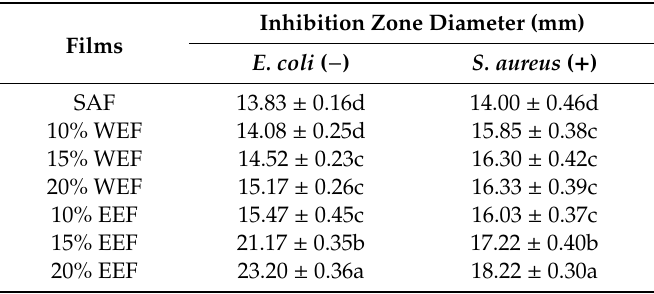
Table 5. Antimicrobial properties of the films.